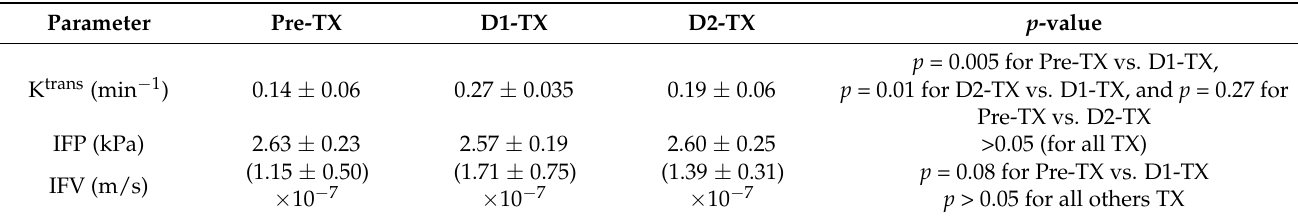
Table 1. K trans , IFP, and IFV values at three-time